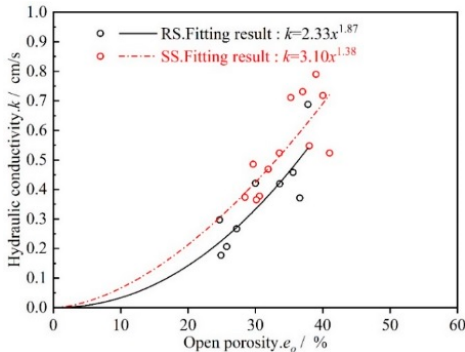
Figure 7. Relationship between the permeability coefficient ( k ) of the RS and SS series microporous ceramic filter membranes and the open porosity ( e o ).